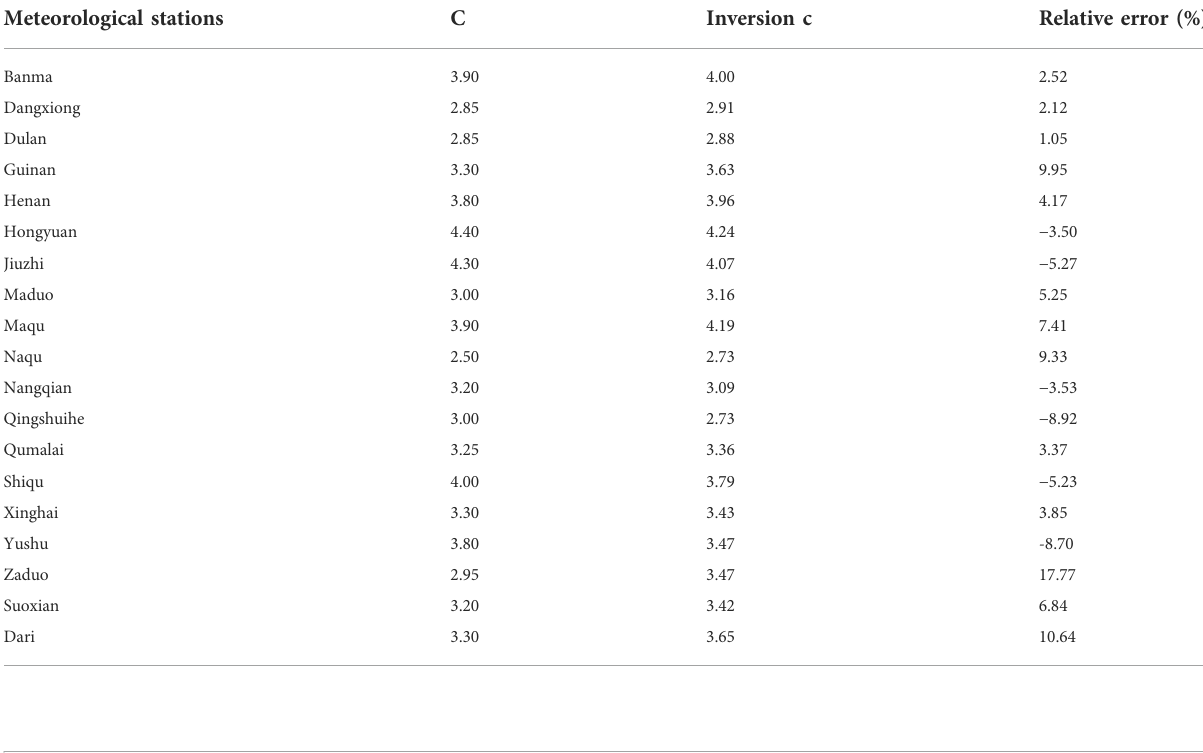
TABLE 3 Parameters, inversion parameters and relative error of 19 stations in and around TRSR. Inversion parameters are calculated by regression Eq. 17. Meteorological stations